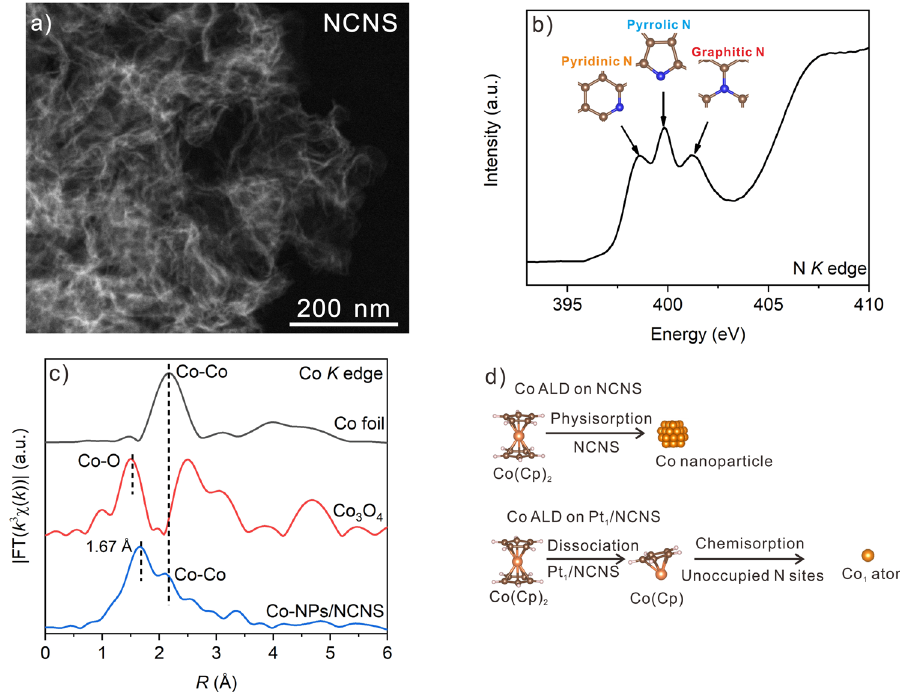
Fig. 1 Characterizations for pristine NCNS, Co-NPs/NCNS, and proposed synthesis strategies for Co SAC. a HAADF-STEM image of NCNS. b XANES of NCNS at N K edge. c FT-EXAFS of Co-NPs/NCNS, as well as Co foil and Co 3 O 4 reference at Co K edge, respectively. d Assumption of the Co ALD process on pristine NCNS and Pt 1 /NCNS. The white, brown, blue, and orange spheres represent H, C, N, and Co,